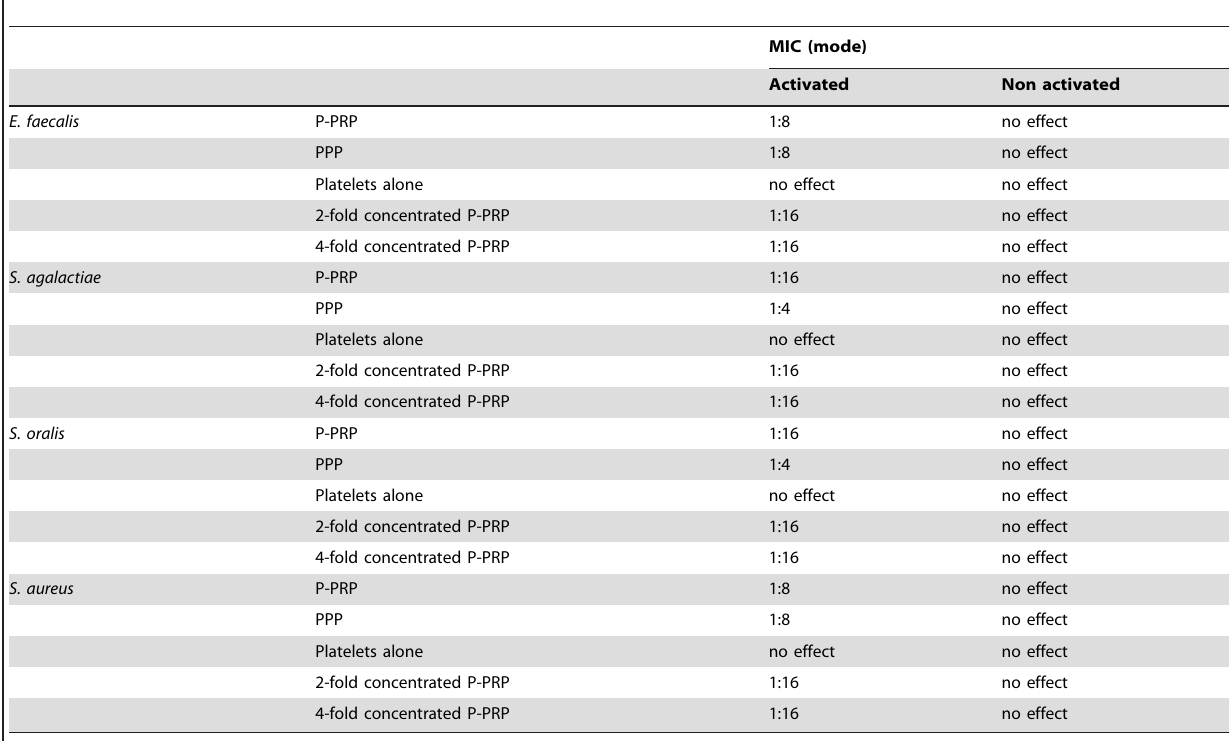
Table 1. Antibacterial activity of platelet concentrates against bacteria isolated from oral